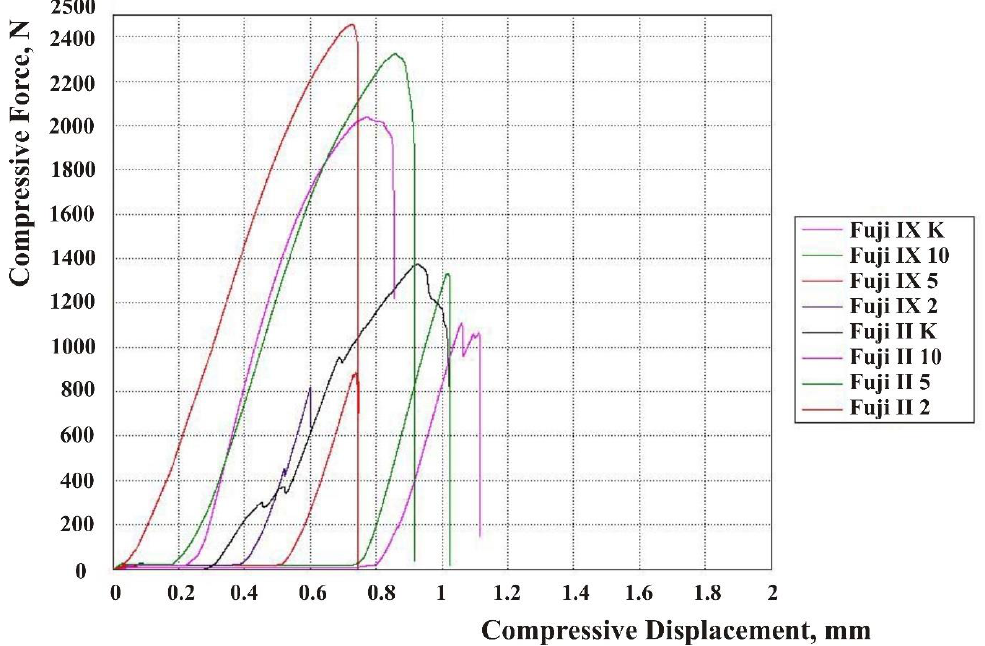
Figure 2. Compressive force-displacement diagram for the Fuji IX and Fuji II groups.